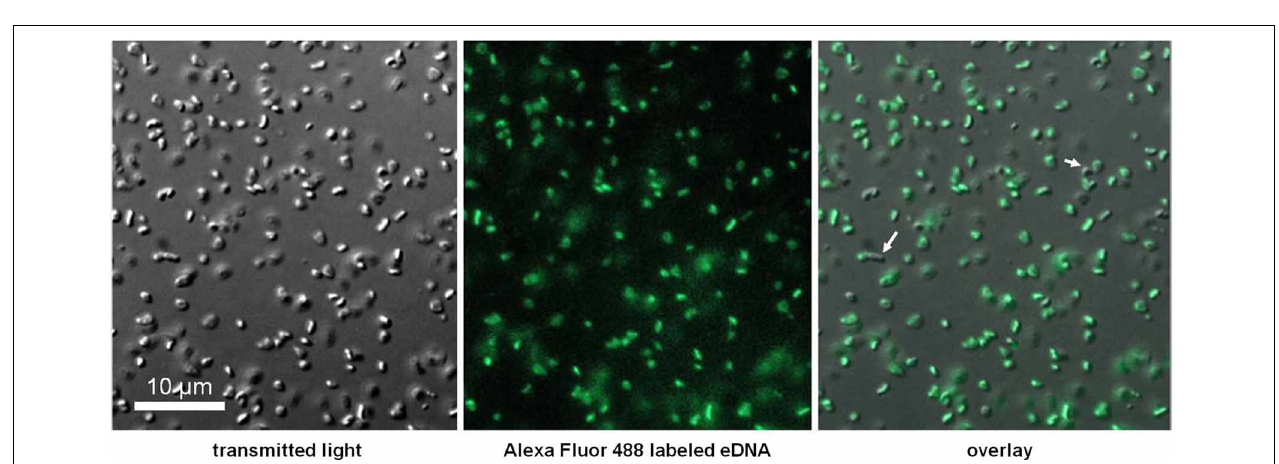
FIGURE 5 | Co-localization of labeled eDNA and Haloferax volcanii cells. Unmethylated E. coli DNA was labeled with Alexa Fluor 488, incubated with starved cells, and visualized at 600 × using an epifluorescence microscope. Auto-fluorescence was not detected at excitation wavelength.